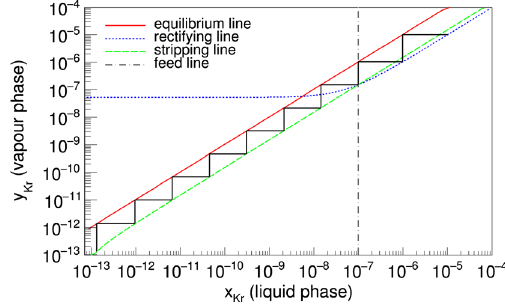
Fig. 2 McCabe–Thiele diagram for the XENON1T requirements. The concentration of the krypton in the gas phase y Kr in relation to the concentration in the liquid phase x Kr . The operation lines for the dif- ferent sections, namely rectifying ( blue dotted line ), stripping ( green dashed line ) and feed line ( grey dash-dotted line ) of the column are drawn and allow for the determination of the number of theoretical stages needed to meet the XENON1T requirements ( black solid line ). The definitions of the equilibrium ( red solid line ) and operation lines are taken